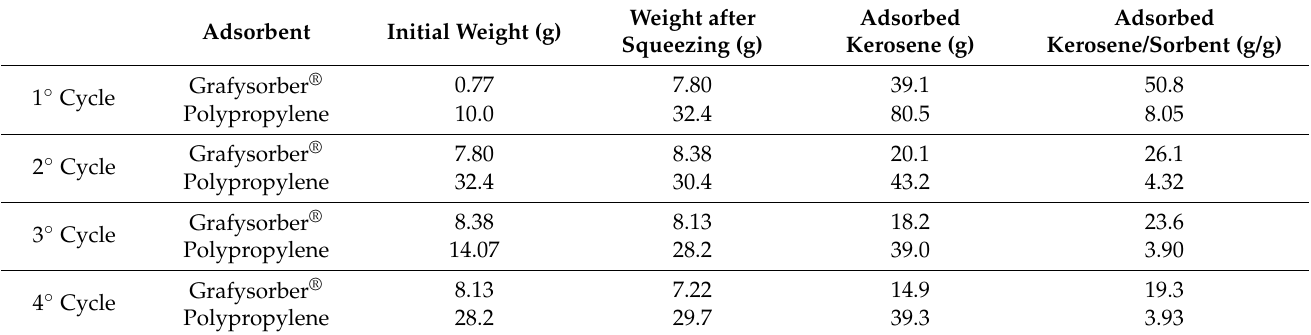
Table 5. Kerosene adsorption tests with Grafysorber ® G+ and Polypropylene.